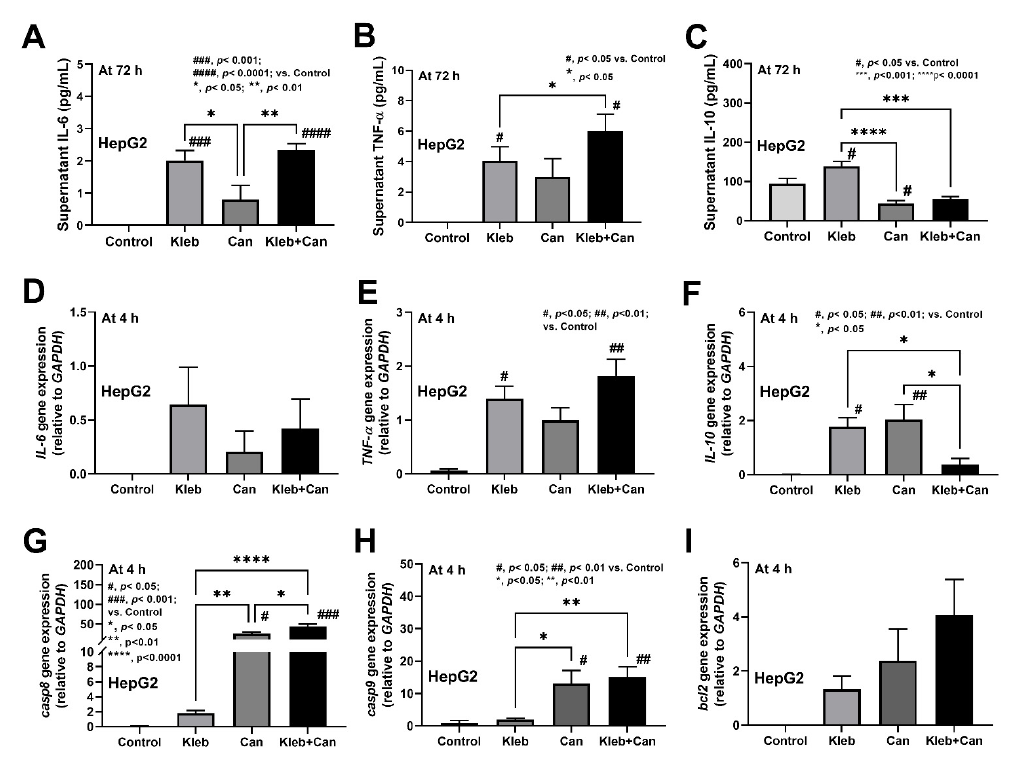
Figure 7. The characteristics of hepatocytes (HepG2 cells) after the activation by media control (control) and the preparations from K. pneumoniae (Kleb) or C. albicans (Can) alone or the combination (Kleb+Can) as indicated by supernatant cytokines (IL-6, TNF- α , and IL-10) at 72 h post-incubation ( A – C ) and the gene expression (4 h post-incubation) of the molecules of inflammation ( IL-6 , TNF- α , and IL-10 ) ( D – F ) and apoptosis ( casp8, casp9, and bcl-2 ) ( G – I ). (Independent triplicated experiments were performed.) #, p < 0.05; ##, p < 0.01; ###, p < 0.001; ####, p < 0.0001 vs. control; *, p < 0.05; **, p < 0.01; ***, p < 0.001; ****, p < 0.0001, the indicated groups as have determined by ANOVA with Tukey’s analysis.